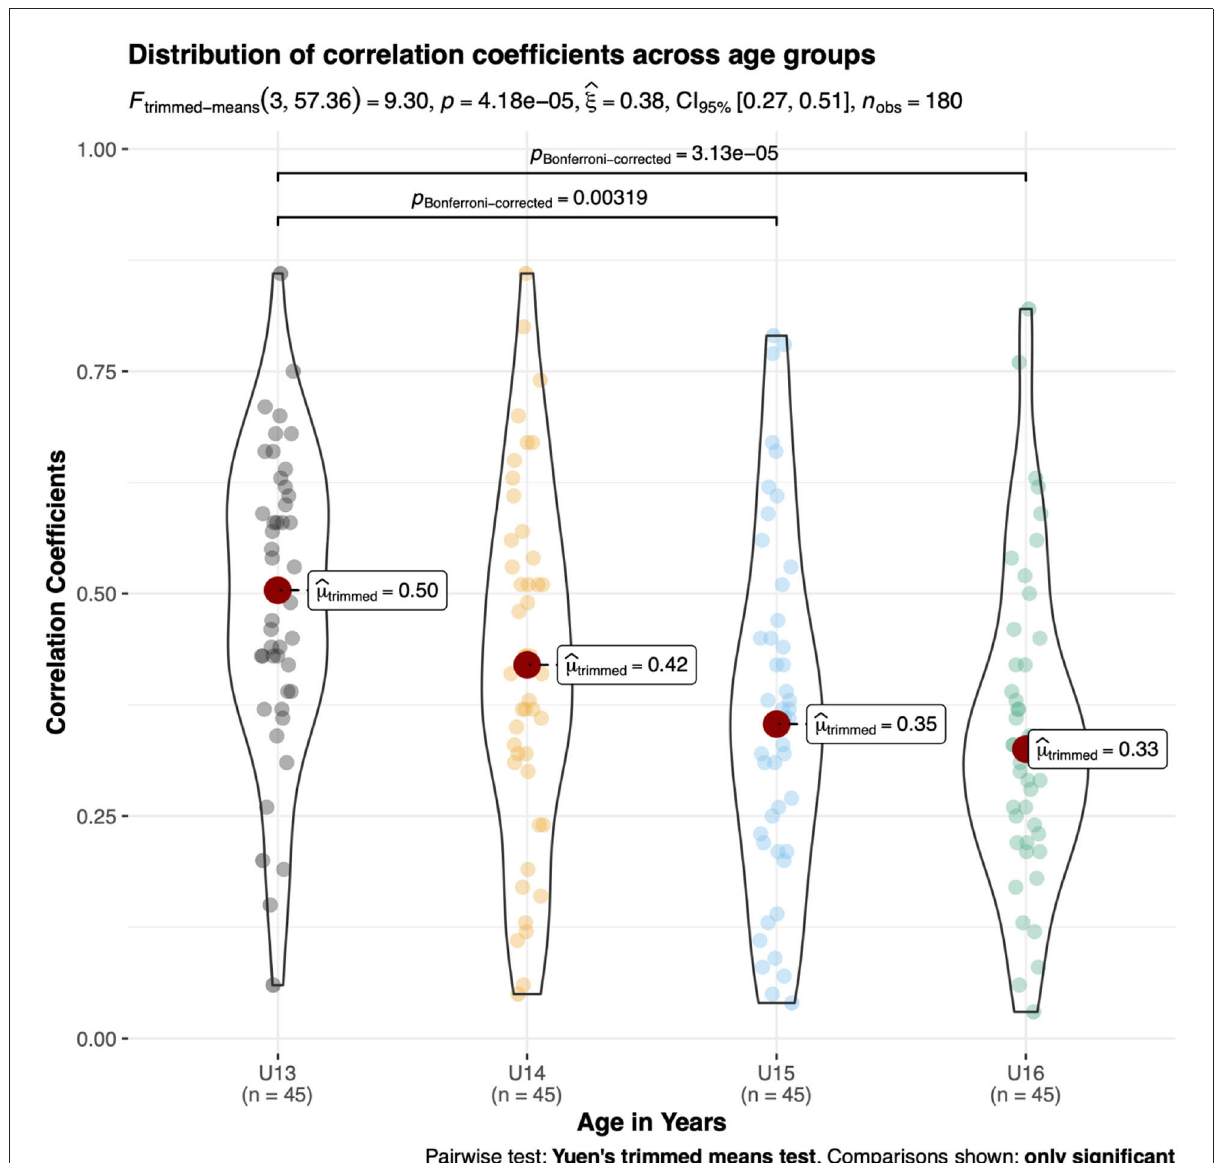
FIGURE4 Post-hoc tests on trimmed means of different age categories of absolute inter-item correlation coefficients in young male